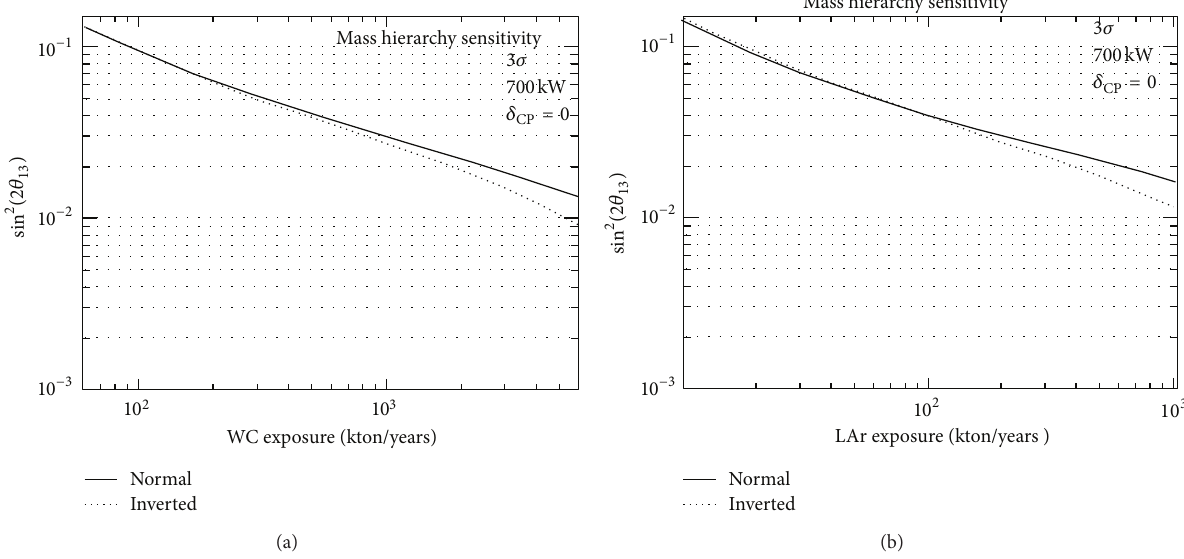
Figure 8: LBNE sensitivity to the mass hierarchy at 3𝜎 as a function of the exposure for WC (a) and LAr (b) detectors. The value of 𝛿 is fixed at 0 but a similar behaviour is expected for other values of the phase. Figures taken from